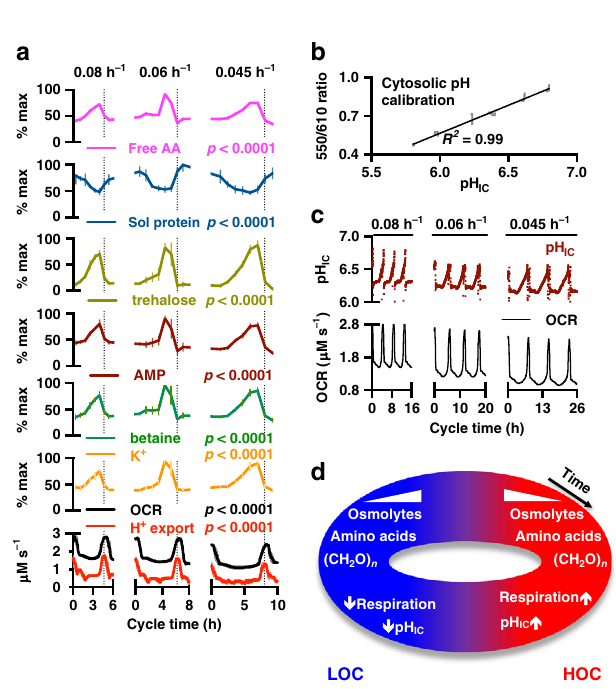
Fig. 2 Variation of metabolites, transport, and soluble protein across the YRO. a There are consistent phase relationships between intracellular free amino acids (AA), soluble (Sol) protein, trehalose (storage carbohydrate), AMP, betaine, K + , OCR and H + export under all conditions ( n = 4 biologically independent samples, two-way ANOVA Time p value shown, mean ± SEM). b Calibration curve for fi re fl y luciferase emission ratiometric reporter of intracellular (cytosolic) pH. c Intracellular pH (pH IC ) oscillates as a function of YRO phase under all conditions (representative data). d Summary of key events that occur during HOC and LOC. Source data are provided as a Source Data fi